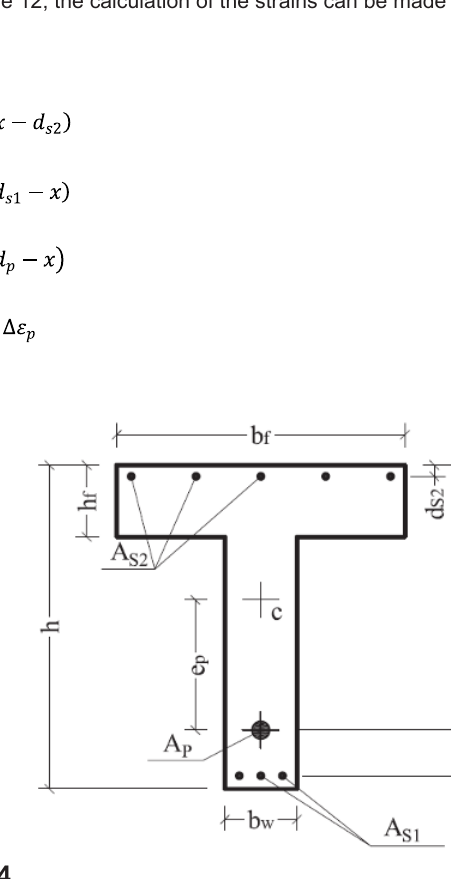
Resultant forces acting on the